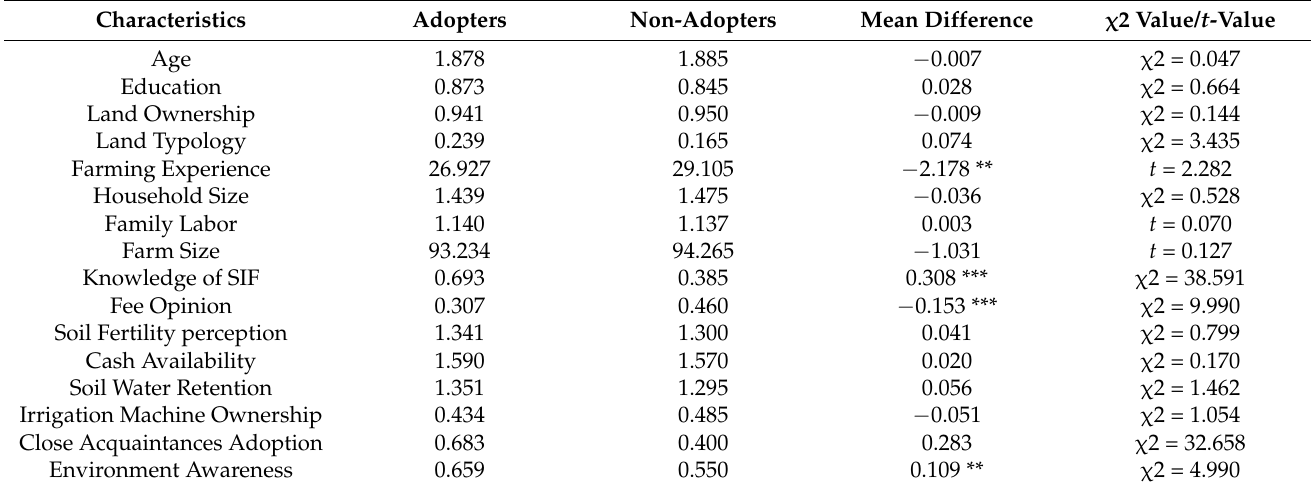
Table 2. Characteristics of the adopters and non-adopters.